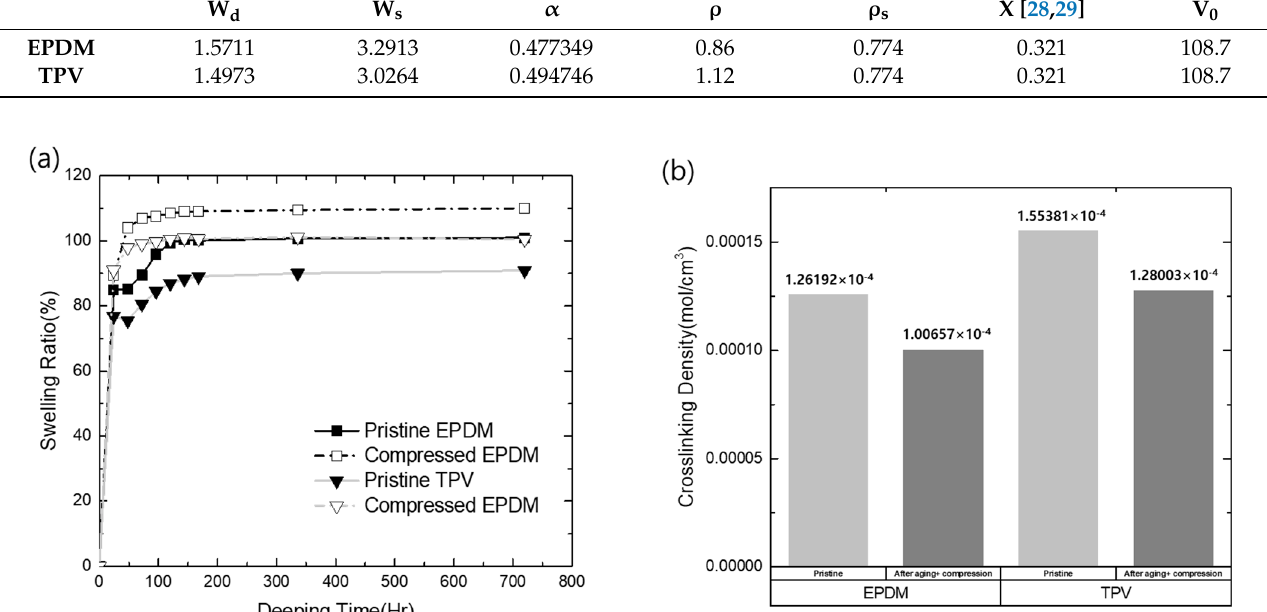
Figure 3. The crosslinking properties of EPDM and TPV: ( a ) swelling ratio changes of EPDM and TPV in cyclohexane; ( b ) calculated crosslinking density values of EPDM and TPV.